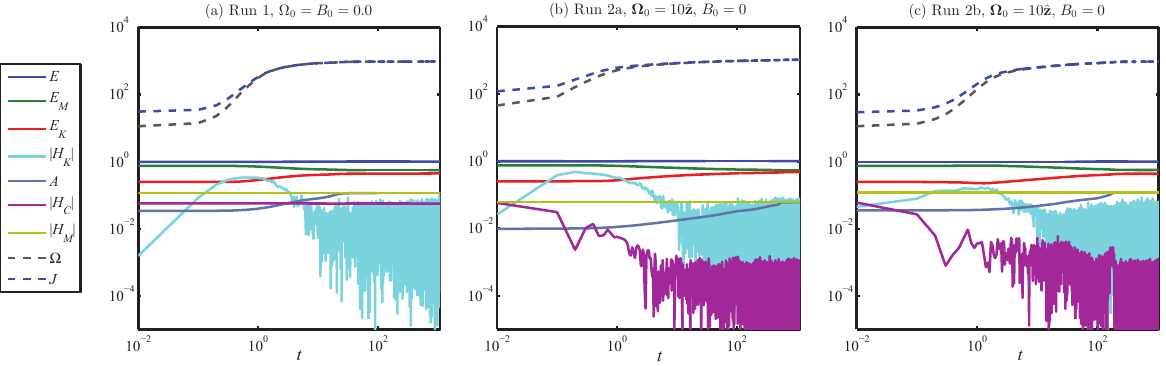
Figure 2. Global quantities (see Appendix A) versus time t for 128 3 homogeneous MHD Runs ( a ) 1, ( b ) 2a and ( c ) 2b. Notice how the integral invariants in Table 1 remain constant in their associated runs.